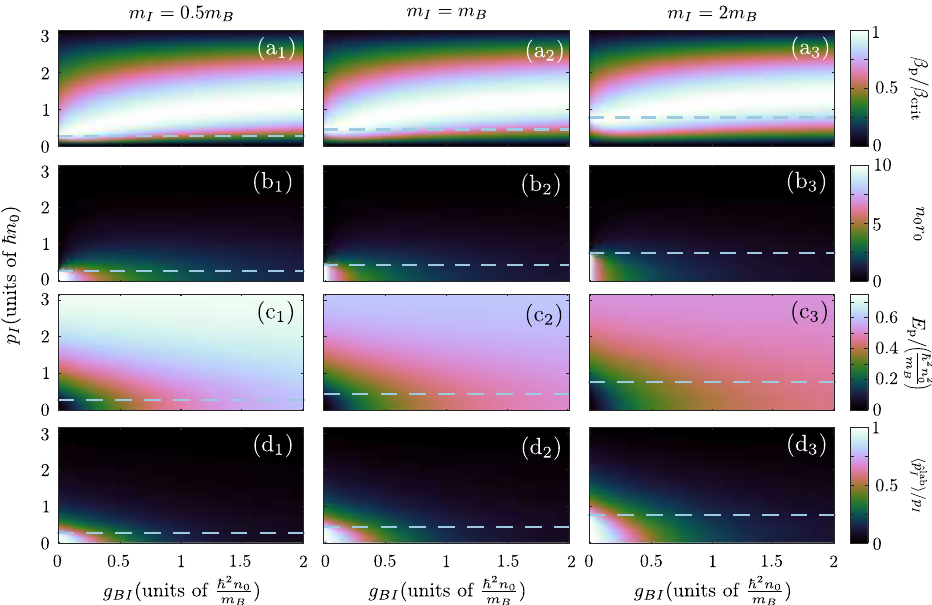
Figure 2. Characteristic properties of the moving Bose polaron within GA. ( a 1 – a 3 ) Velocity of the polaron over its critical one, β p / β crit , ( b 1 – b 3 ) offset parameter, r 0 , of the polaron solution, ( c 1 – c 3 ) polaron energy, E p and ( d 1 – d 3 ) expectation value ratio of the impurity momentum between the (cid:105) / p laboratory and the impurity frames, (cid:104) ˆ p lab I , for different values of g BI and p I . The distinct I columns correspond to different impurity masses, m I = m B /2 (left panels), m I = m B (middle panels) and m I = 2 m B (right panels). In all cases, the data correspond to thermodynamic limit calculations, N , L → ∞ , with g BB = 0.1¯ h 2 n 0 / m B and dashed lines represent p I = m I c